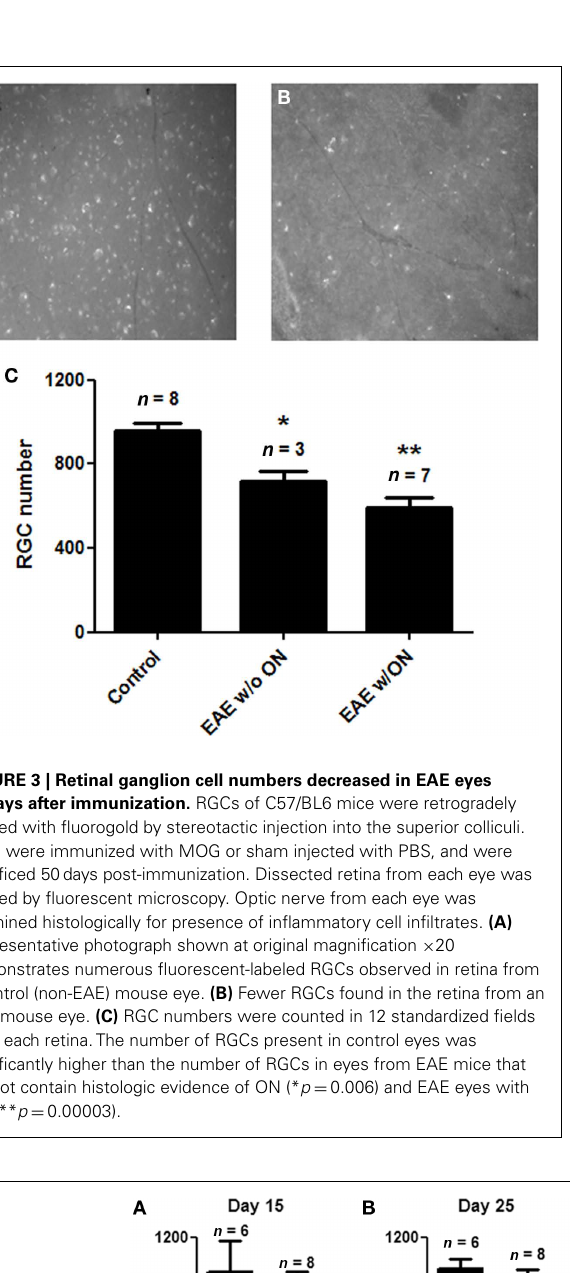
FIGURE 4 | Retinal ganglion cell loss occurs more than 25days after immunization to induce EAE. RGCs were labeled with fluorogold, and mice were immunized with MOG or sham injected with PBS. Mice were euthanized 15, 25, 35, or 40days post-immunization and isolated retina from each eye was viewed by fluorescent microscopy. Optic nerves were examined histologically for presence of